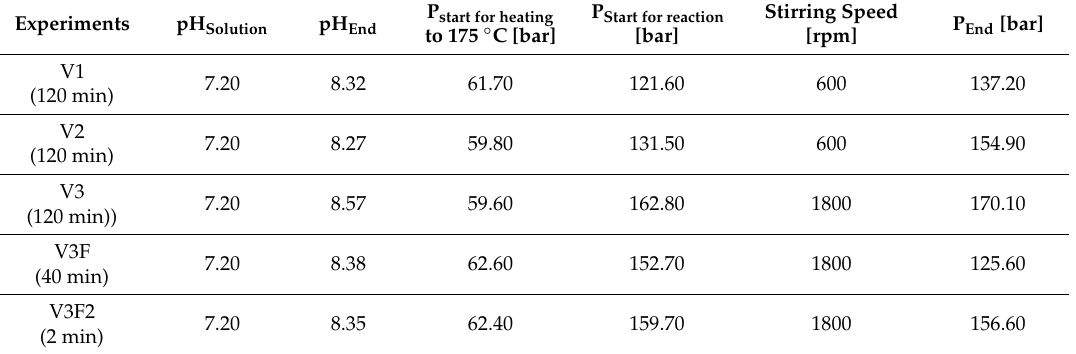
Table 3. The change of pH-Value of solution and pressure during a heating and carbonation.